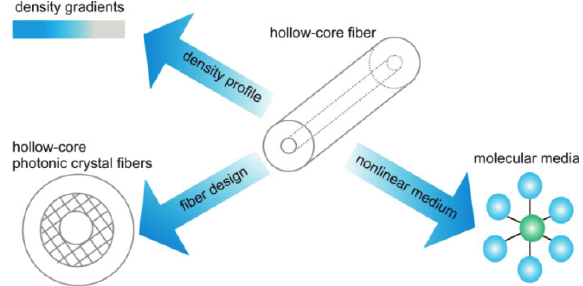
Figure 1. Improvement approaches for application of gas-filled hollow-core fibers for spectral